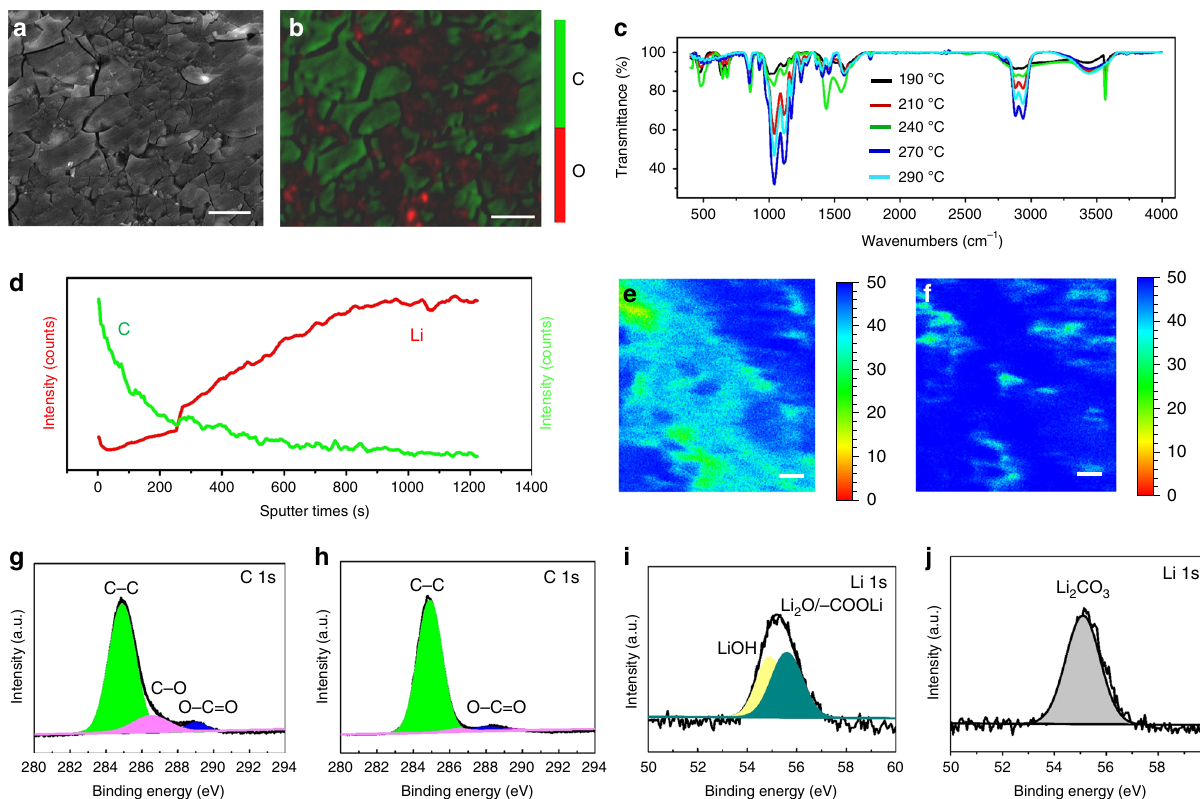
Fig. 3 Mechanism of improved wettability on planar Cu by coating the substrate with abietic resin. a EPMA image of the bottom surface of ultrathin Li when it peeled off from the Cu substrate. b Elemental distribution image of O and C on the bottom surface. c Fourier infrared spectra of ultrathin Li on the bottom surface of the substrate. d Elemental distribution of Li + and C + probed via Tof-SIMS. e Elemental distribution map of Li + on the bottom surface of ultrathin Li after etching 50 layers. f Elemental distribution map of Li + on the bottom layer of ultrathin Li after etching 179 layers. g XPS spectra of C 1 s for the abietic resin coating. XPS spectra of C 1 s ( h ) and Li 1s ( i ) on the bottom surface of ultrathin Li layer when peeled off from the Cu substrate. j XPS spectra of Li 1 s for the bottom surface of ultrathin Li after the carbon-enriched layer was removed by DOL. Scale bars are 20 µ m in a , b , e ,